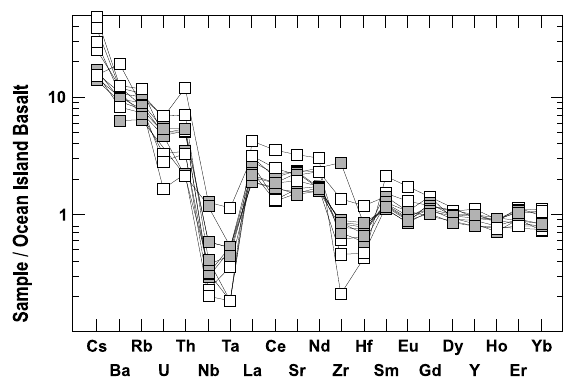
Fig. 9 – Spidergram for trace elements in the Piquiri Syenite Massif syenites normalized against the OIB values of Sun (1980). Symbols as in Figure